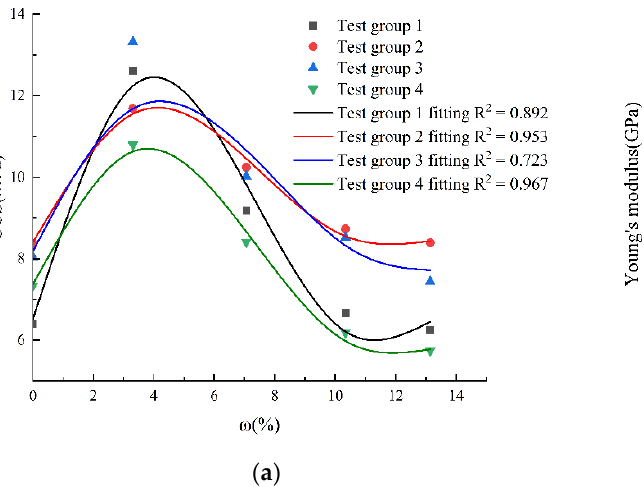
Figure 6. A diagram of the water filling and compression failure of the coal micro-pore structure. ( a ) Water filling of pore structure; ( b ) compression failure of pore structure.